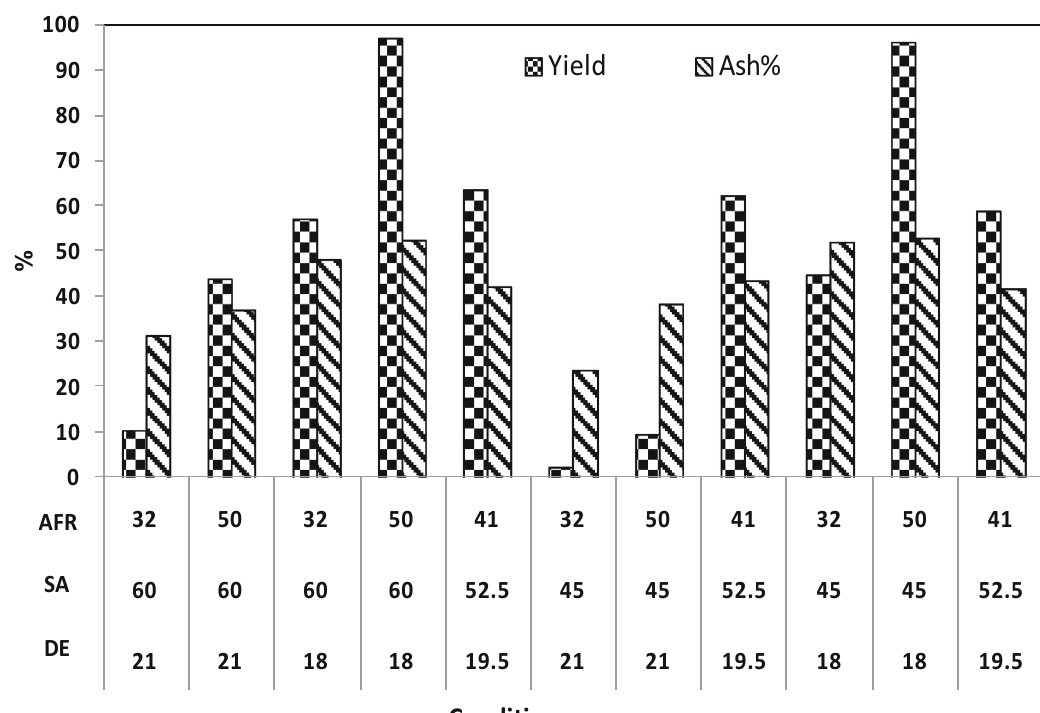
Fig. 5 Separation behavior at different